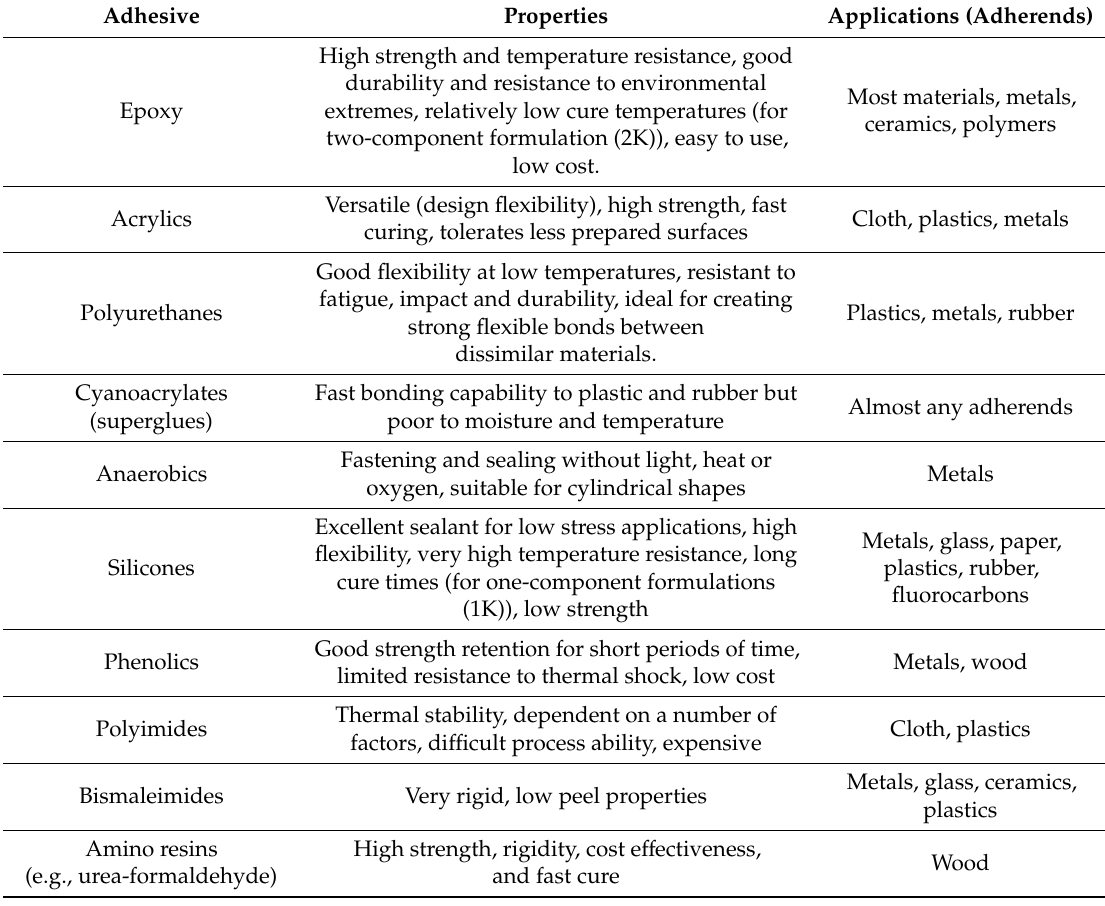
Table 1. Classification of synthetic adhesives and sealants